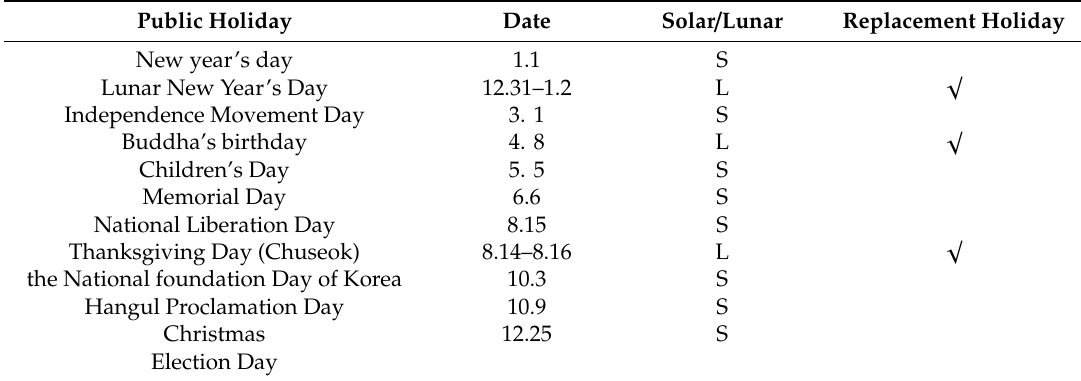
Table 4. Features of Korean